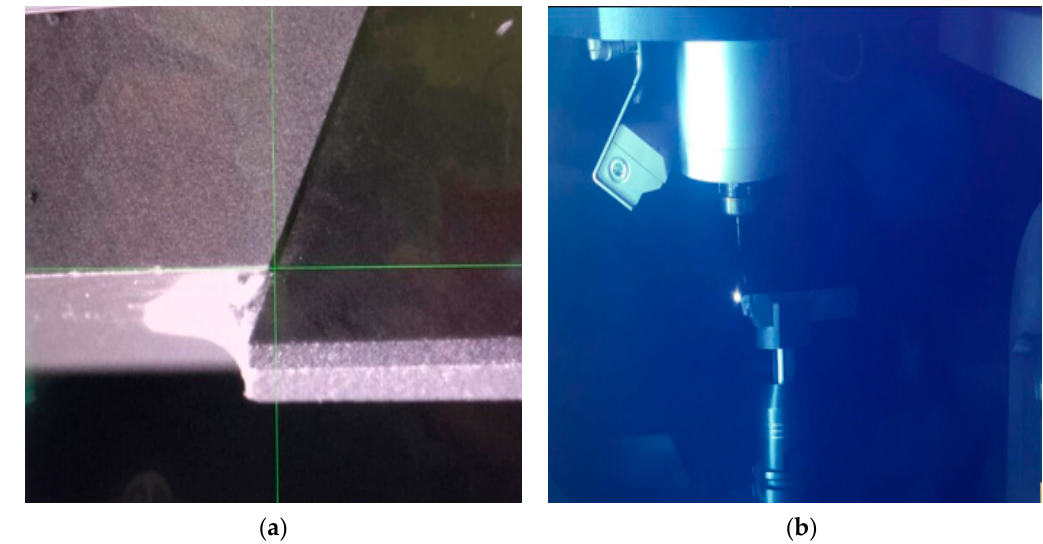
Figure 6. ( a ) Calibration of the machine before LASER sharpening of the cutting insert; ( b ) Sharpening of the cutting insert with LASER CNC Lasertec 20.